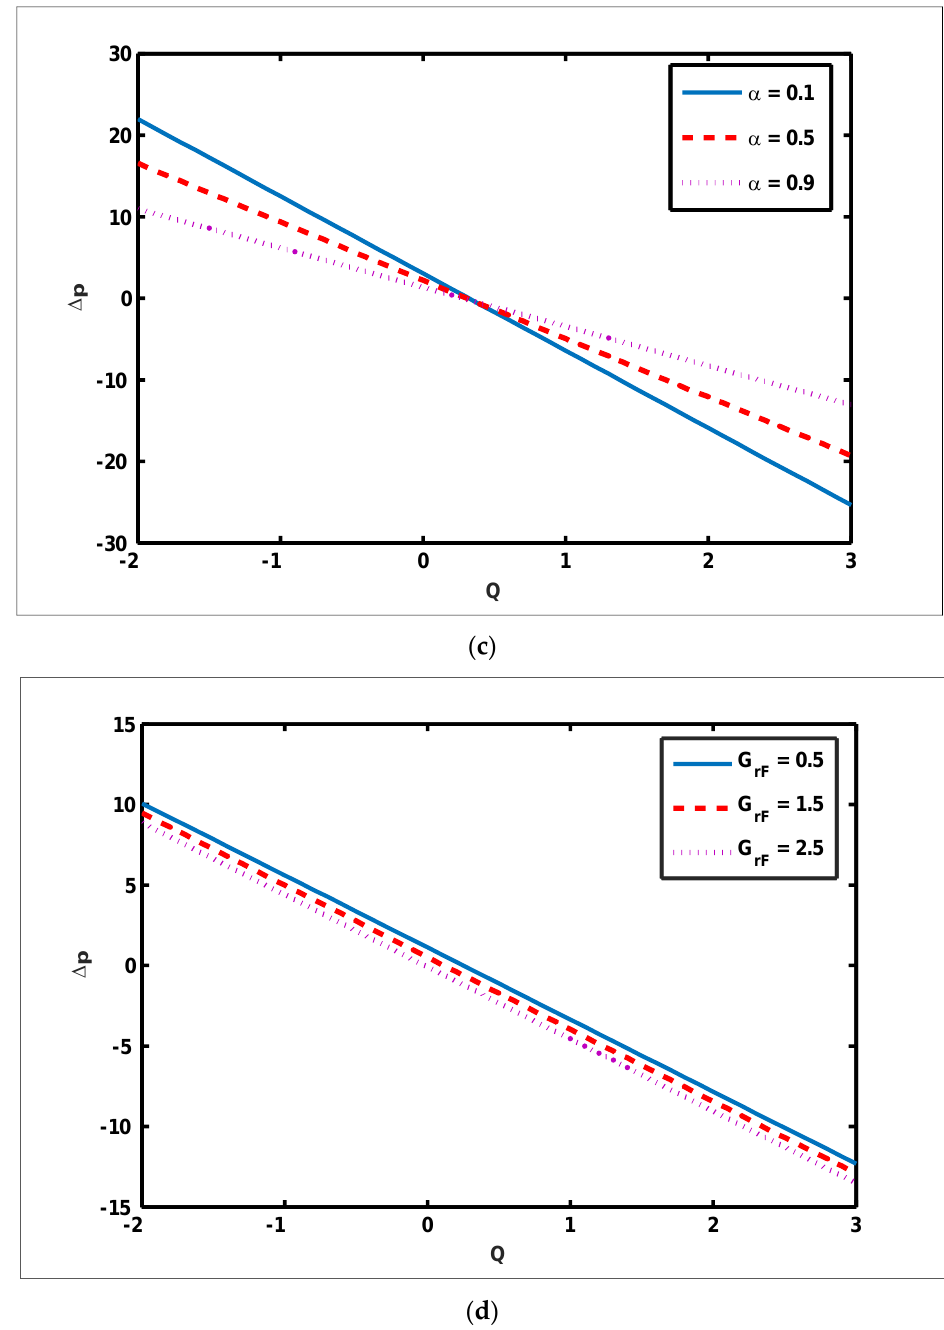
Figure 4. Effect of Weissenberg number, Reynolds number, slip parameter, and Grashof number of nanoparticles on pressure rise. ( a ) N t = 0.3, N TC = 1.2, N b = 0.4, b = 0.7, a = 0.3, N CT = 0.9, x = 0.1, Re = 0.5, S 1 = 0.3, R m = 0.5, E = 0.5, G rc = 1, G rt = 0.5, G rF = 0.8, α = 0.8, (cid:101) η = 1, (cid:101) µ = 1